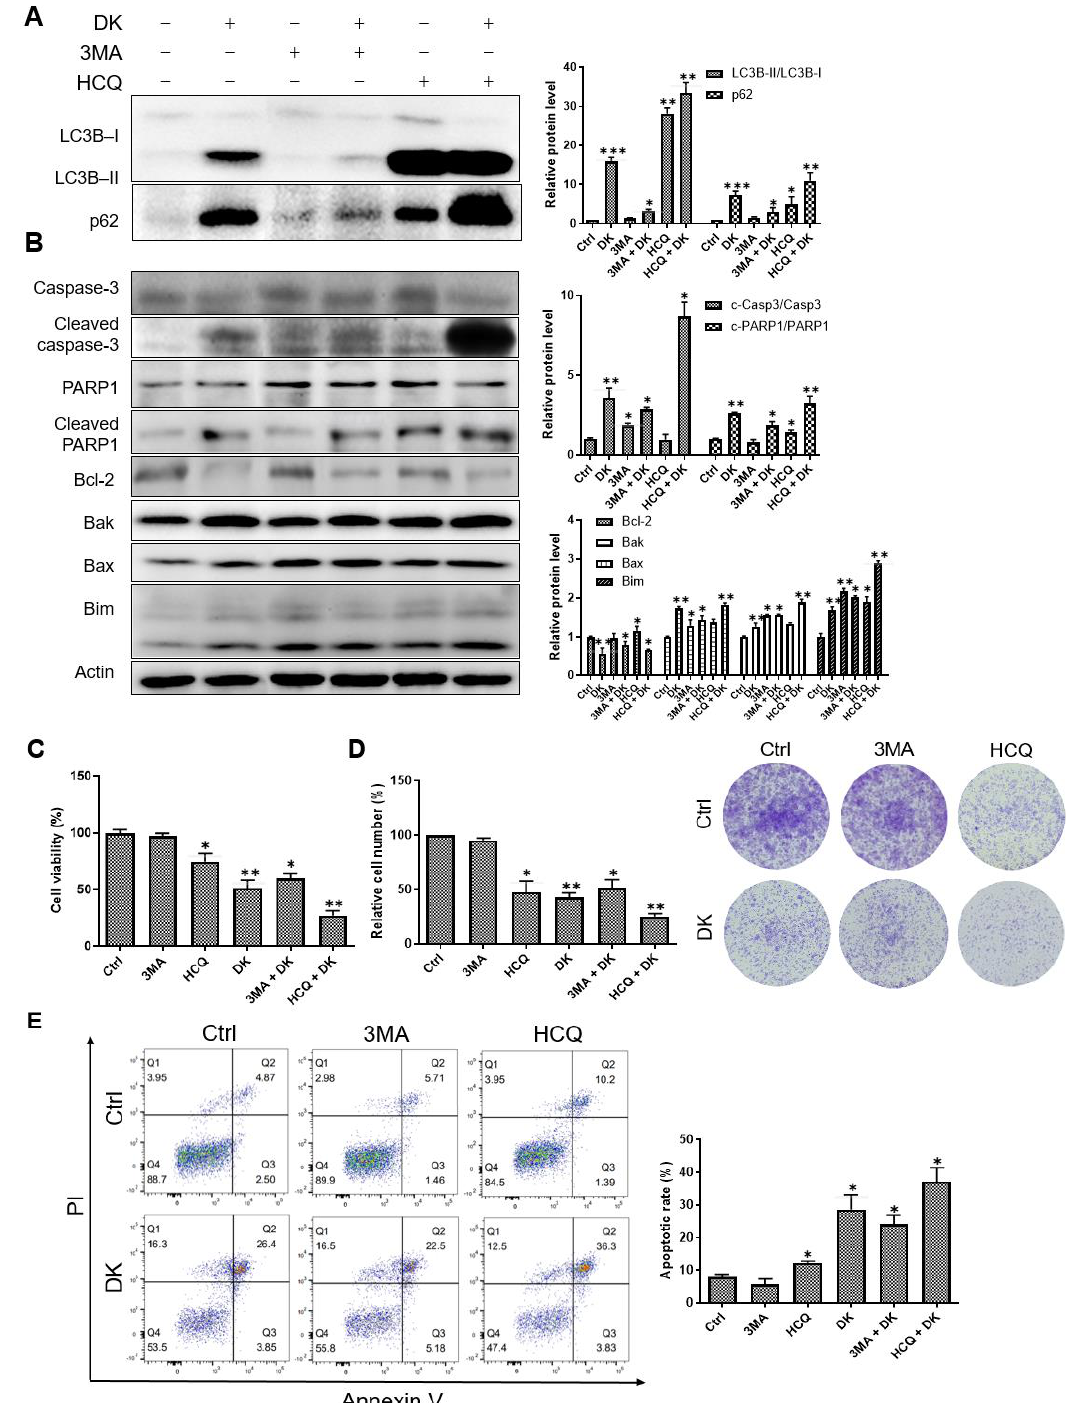
Figure 4. Inhibition of autophagy flux contributes to dieckol (DK)-induced cell death in A375 human melanoma cells. ( A , B ) A375 cells were treated with 3-methyladenine (3MA, 0.1 mM) or hydroxychloroquine (HCQ, 15 µ M) in the presence or absence of 25 µ M DK for 48 h, and cell lysates were analyzed by Western blotting for endogenous proteins. Representative images are shown. The expression levels of proteins were quantified by image J densitometric analysis. Results are shown as mean ± standard deviation (SD) of triplicate independent experiments. ( C – E ) Cells were treated the same as in ( A ). Cell viability, colony formation ability, and Annexin-positive apoptotic cells were analyzed. Results are quantified and shown as mean ± SD of triplicate independent experiments. *** p < 0.001, ** p < 0.01, * p < 0.05 compared to the